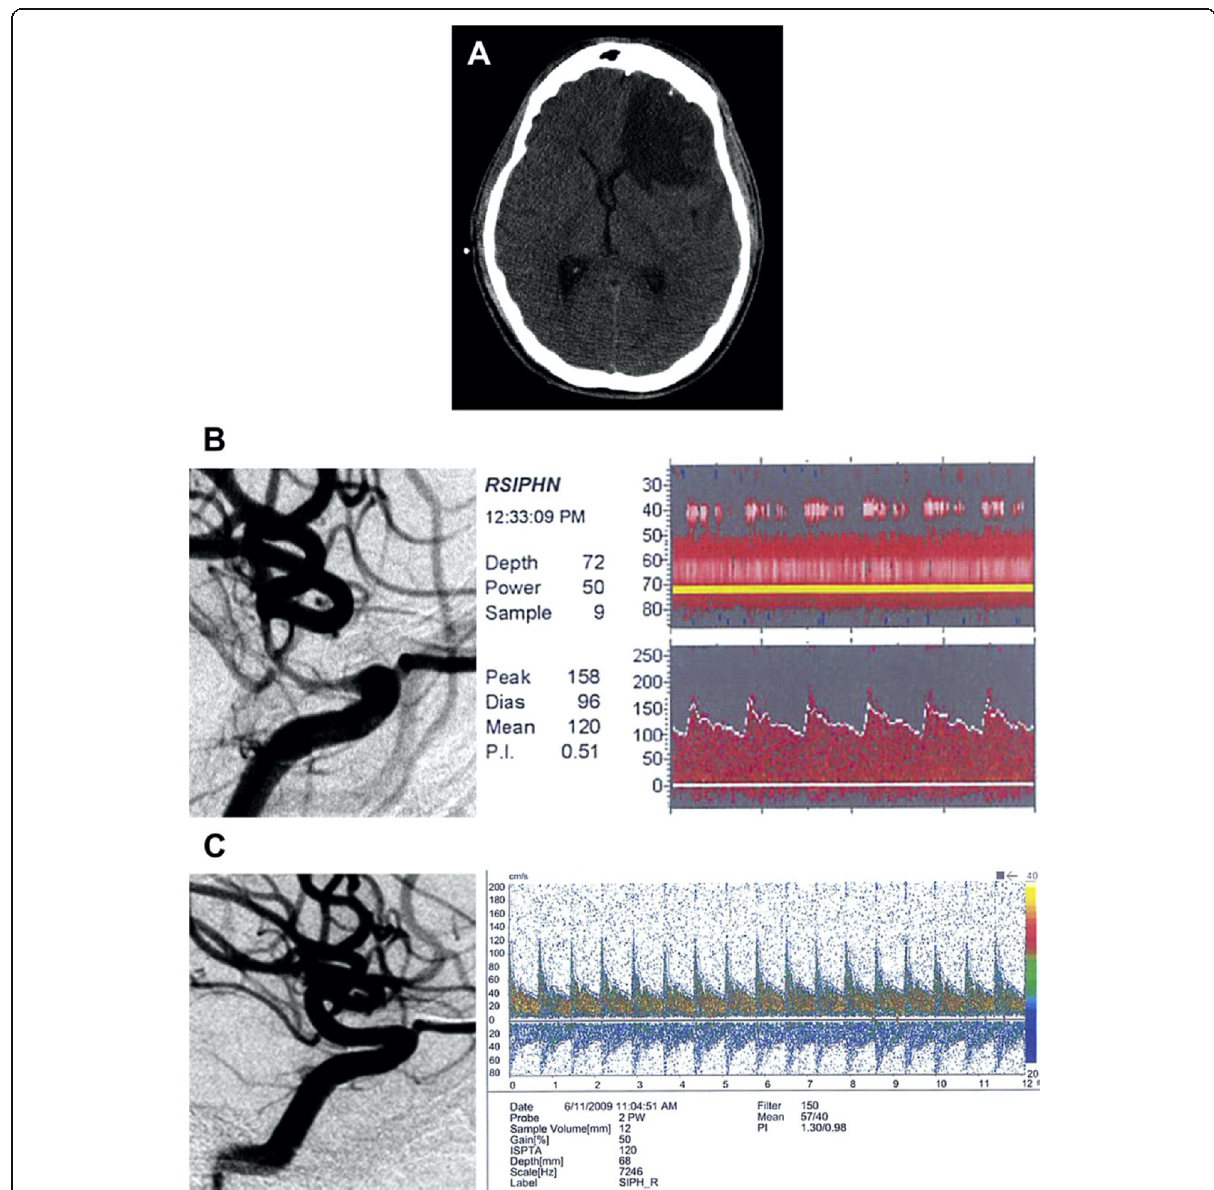
Fig. 3 Patient with right side contusion. a CT scan demonstrating contusion. b Right common carotid artery injection showing severe vasospasm affecting right carotid siphon before angioplasty and corresponding TCD measured CBFV in the right carotid siphon. c Resolution of vasospasm after transluminal angioplasty and TCD showed CBFV normalization after angioplasty